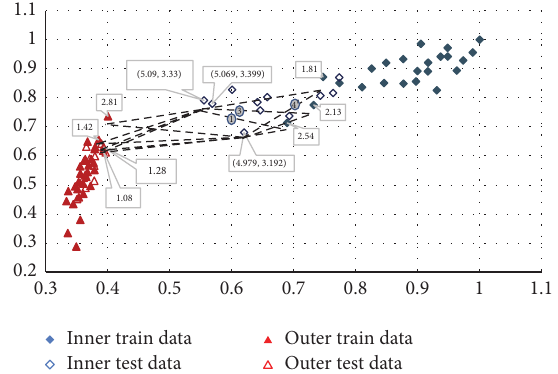
Figure 10: The classification of unknown test samples using LOF based density similarity